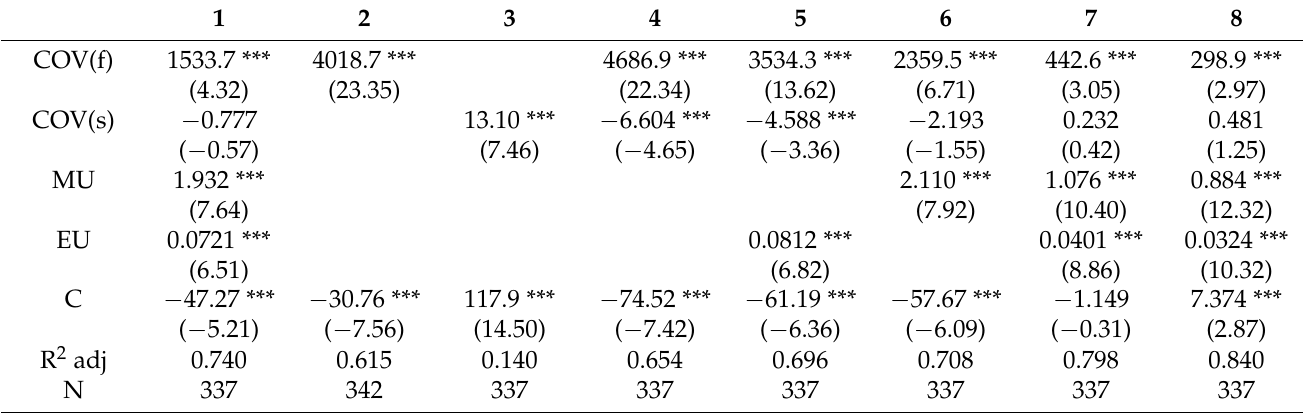
Table 6. COVID-19 death announcements, Japanese volatility, and oil price volatility, Asian